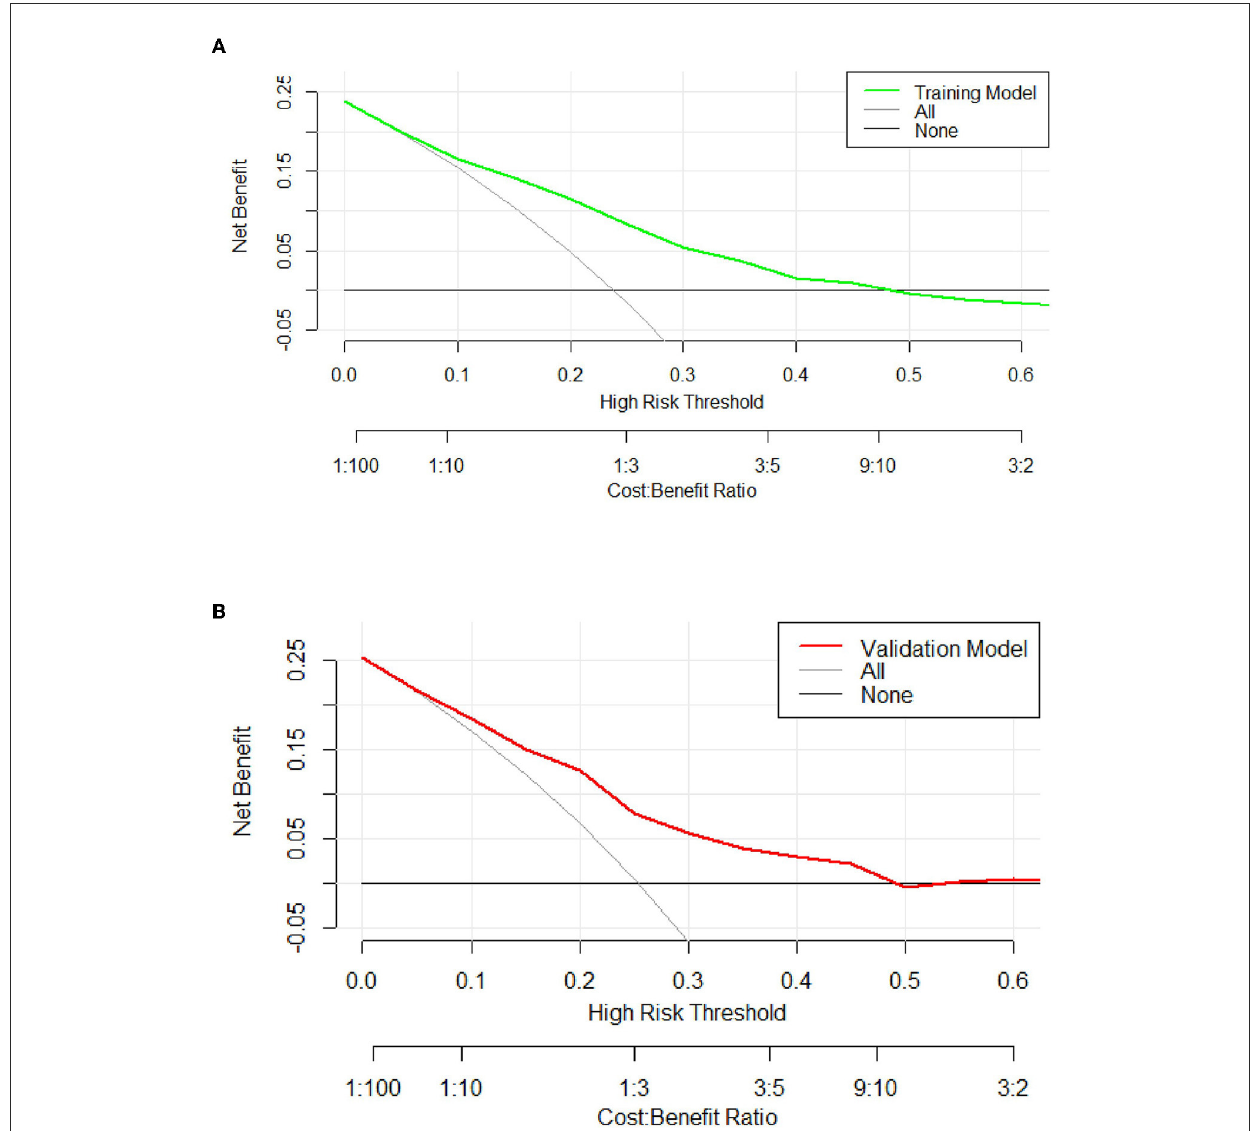
FIGURE6 The decision curve of the model in the training (A) and validation (B) cohort. If the risk threshold is < 50%, the nomogram model will obtain more benefit than all treatments (assuming that all neurology department patients were PE) or no treatment (assuming all neurology department patients were